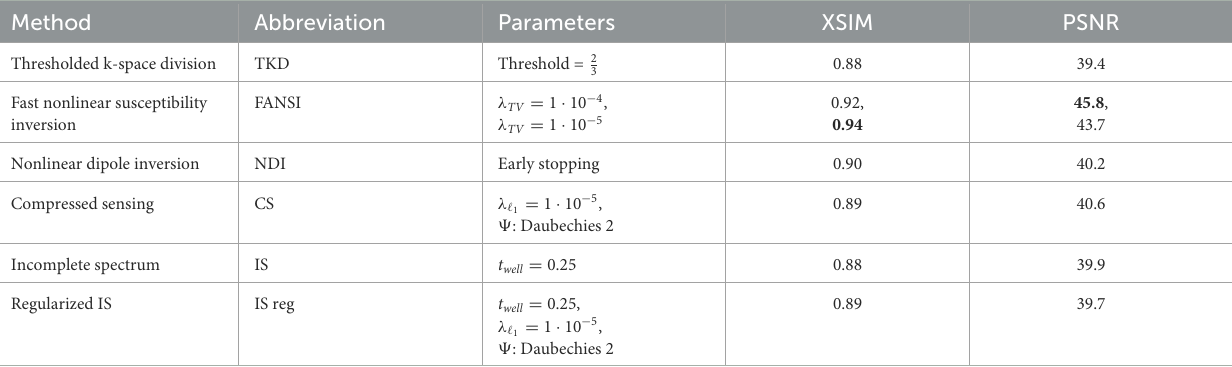
TABLE 1 Reconstruction methods that were compared with the incomplete spectrum approach on the in vivo dataset and their parameters tuned for optimal PSNR in the numerical phantom.